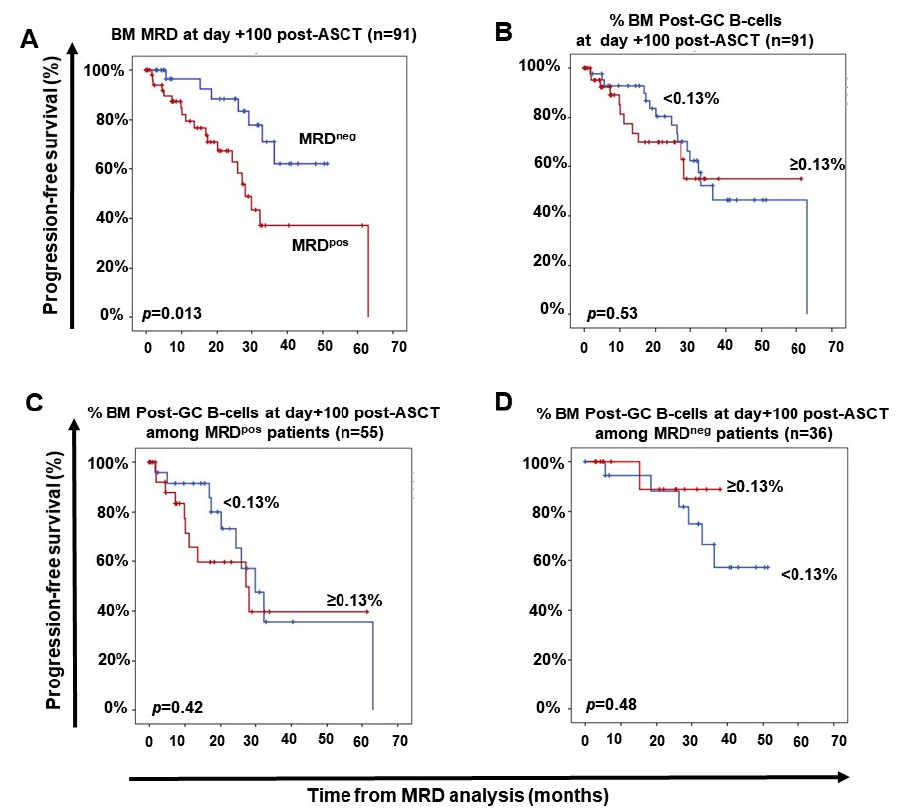
Figure 3. Impact of measurable residual disease (MRD) and the distribution of normal residual post-germinal center B-cells in BM of MM at day+100 after autologous stem cell transplantation (ASCT) on patient progression-free survival (PFS). In panel ( A ), the impact of BM MRD on PFS is shown. PFS of treated MM patients grouped according to the number of residual post-germinal center B-cells (memory B-cells plus nPC) in BM at day+100 post-ASCT ( B ) and in MM patients stratified according to the presence ( C ) vs . absence of MRD ( D ) at day+100 post-ASCT, is shown. BM, bone marrow; MM, multiple myeloma.